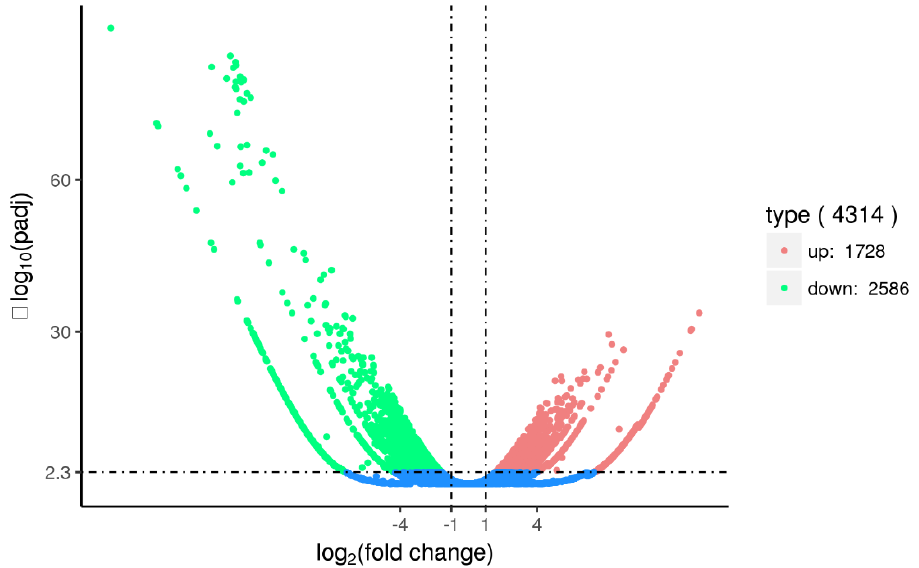
Figure 7. Gene transcription profile volcano plot of the control and treatment group. Red points indicate up-regulated genes. Green points indicate down-regulated genes.